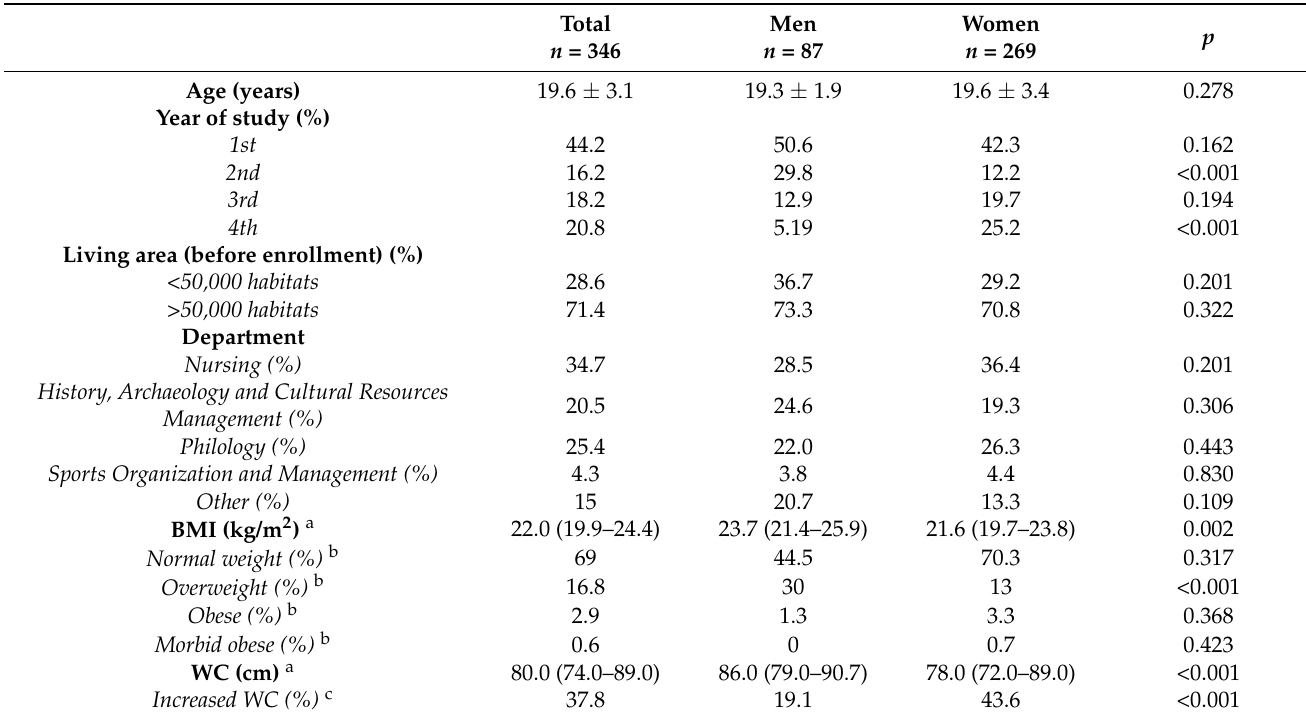
Table 1. Descriptive characteristics of